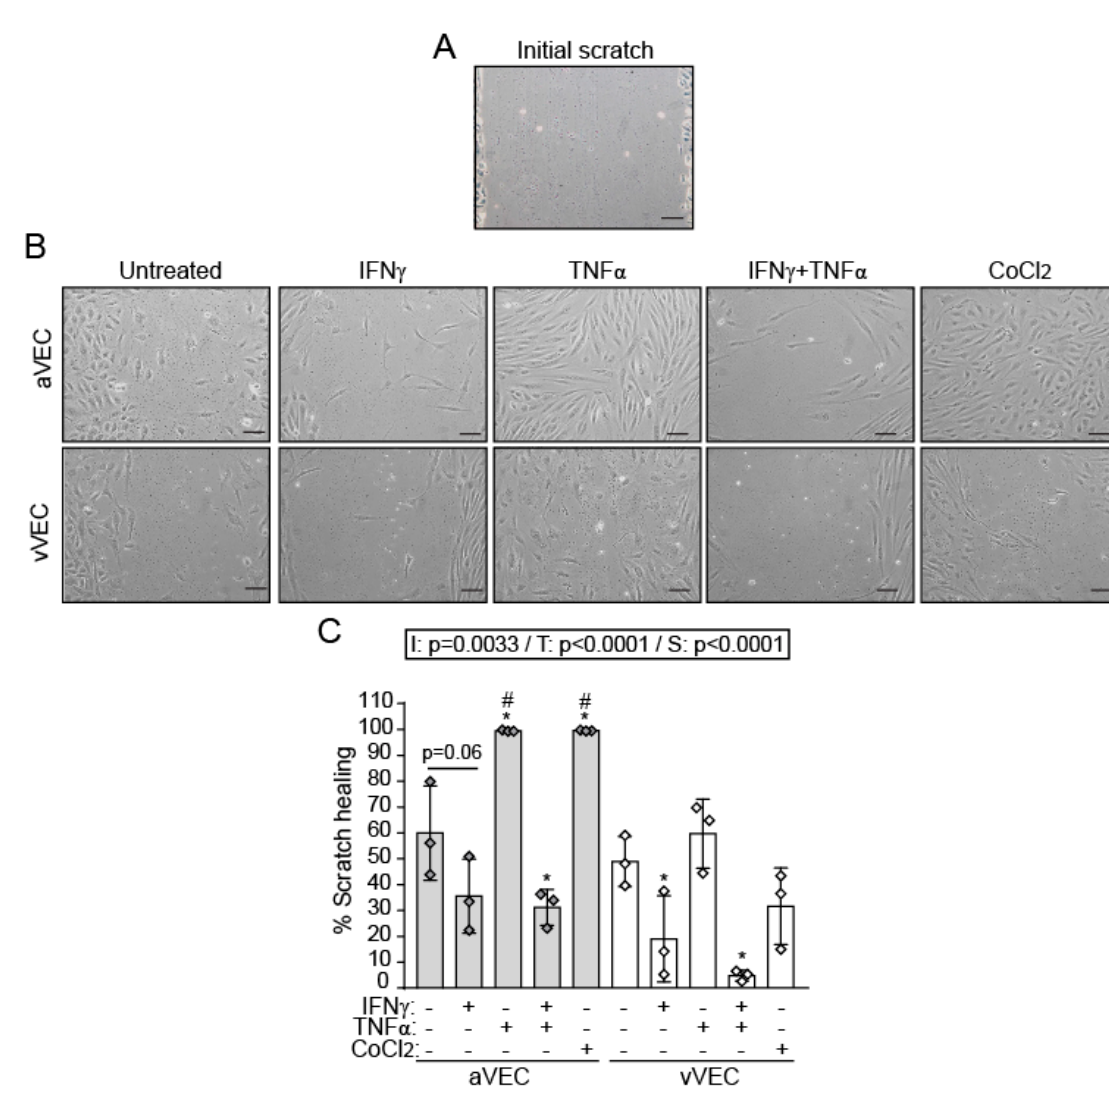
Figure 4. TNF- α and CoCl 2 promote migration of aVEC under multiaxial flow conditions, while IFN- γ reduces TNF- α -mediated migration. aVEC and vVEC monolayers were sheared and activated for 24 h in parallel, and the wound-healing assay was performed as indicated in Methods. ( A , B ) Representative photograph of the scratch size in the aVEC and vVEC monolayers at the center of the wells (multiaxial flow), at 0 ( A ), and 24 h ( B ) time points. ( C ) % scratch healing was analyzed for each condition in n = 3 aVEC-vVEC pairs from independent valve donors. Dataset C: Mean ± S.D. 2-Way ANOVA statistics are shown above the graph; I = interaction between treatment and valve side; T = treatment; S = valve side. * p < 0.05 compared to the control group (Dunnet test). # p < 0.05 compared to the same treatment in the other group (Sidak test).